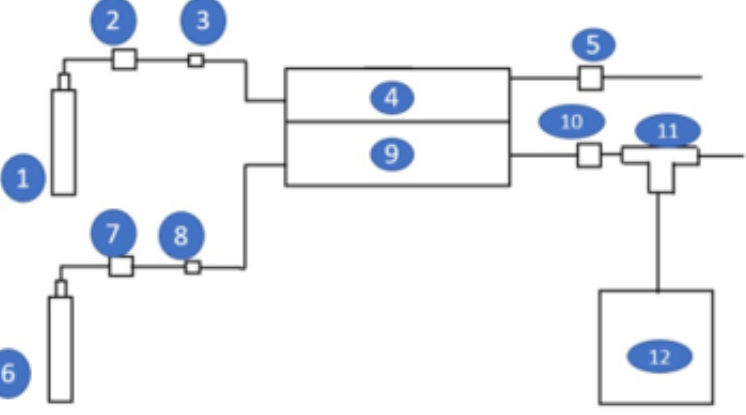
Figure 1. Diagram of the hydrogen permeability test bench.